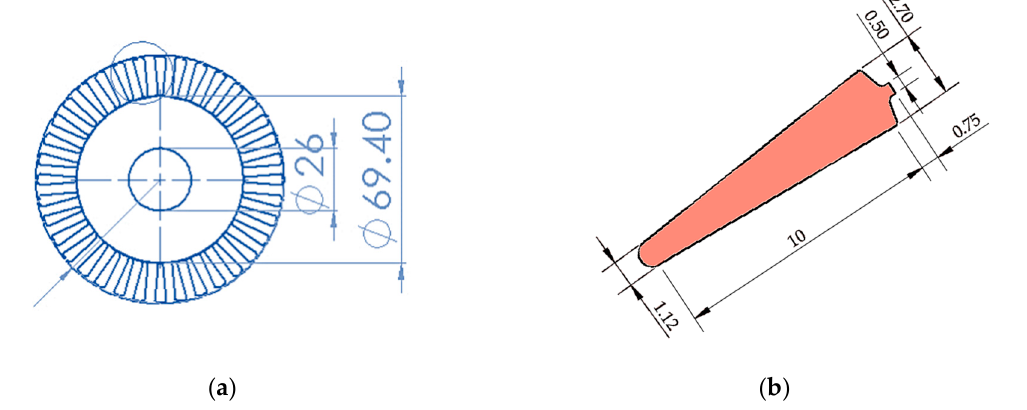
Figure 3. Geometrical dimensions of induction generator. ( a ) Rotor core, ( b ) Rotor bar.